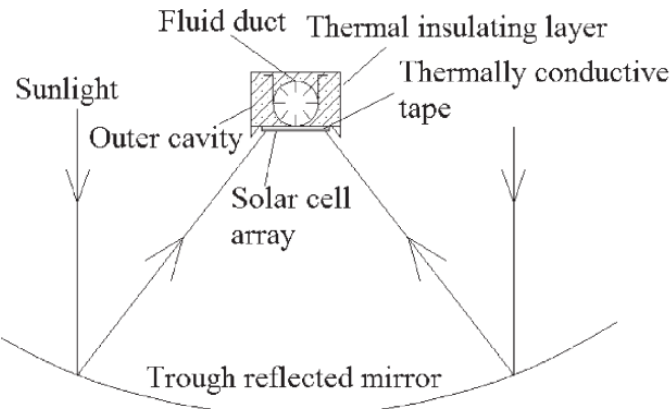
Figure 8. The cross-sectional view of the CPVT system tested in [84]. Reprinted with permission from Ref. [84]. 2011, Elsevier.